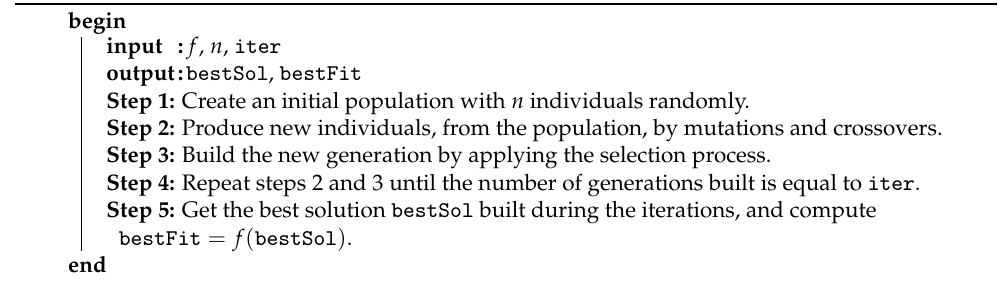
Algorithm 1: General structure of a